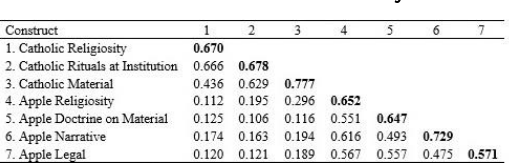
Table 4: Discriminant